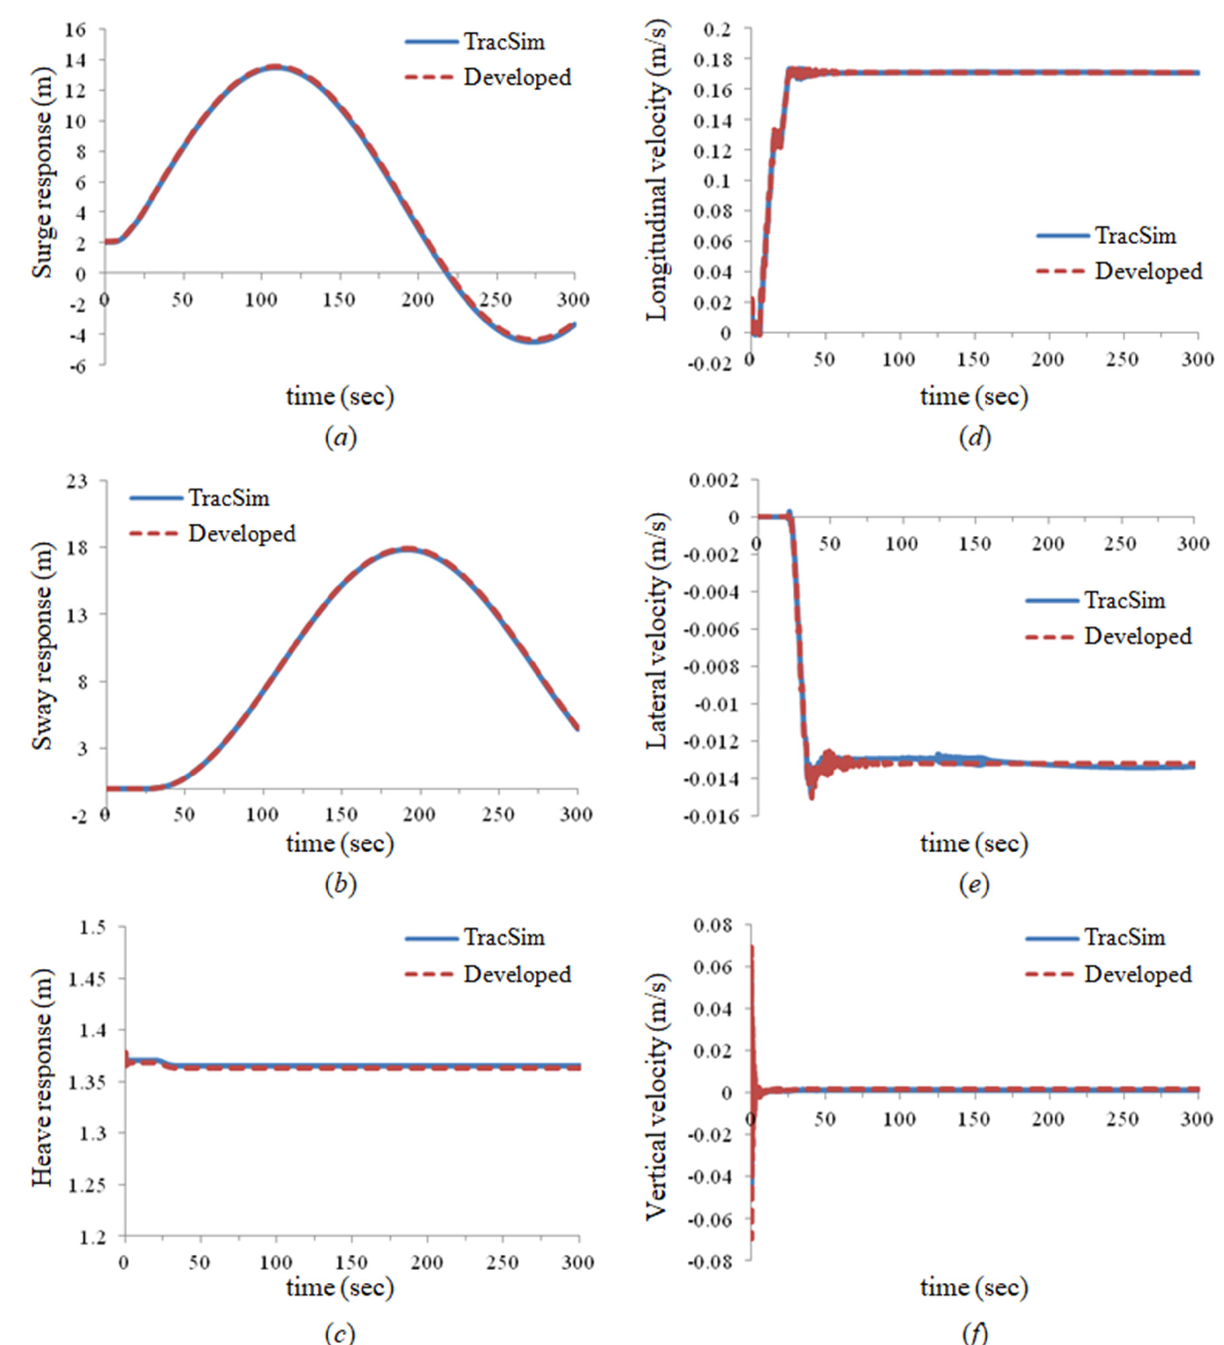
Figure 29. Comparison of the steering drive dynamic analysis results between the developed method and Tracsim: ( a ) surge response of the mining robot, ( b ) sway response of the mining robot, ( c ) heave response of the mining robot, ( d ) longitudinal velocity of the mining robot, ( e ) lateral velocity of the mining robot, ( f ) transverse velocity of the mining robot.